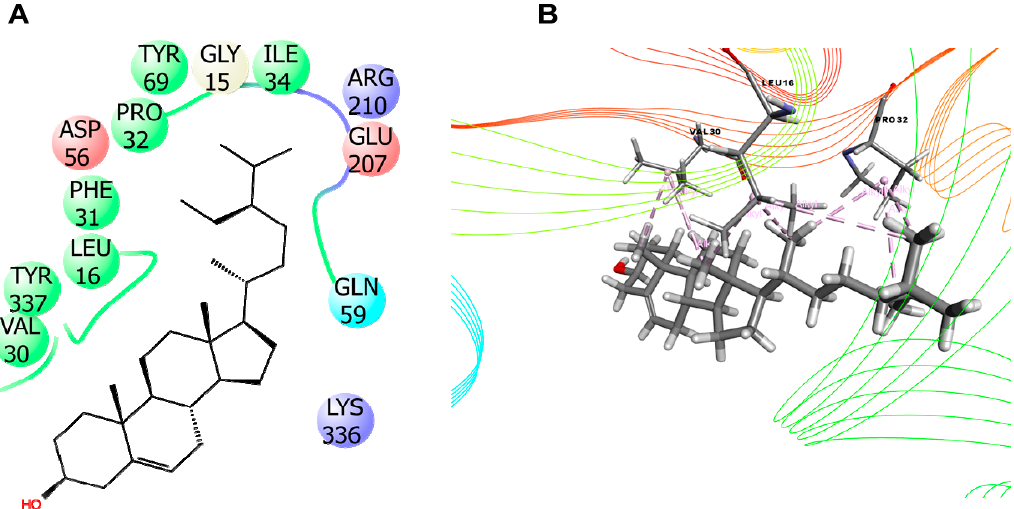
Figure 7. The best 2D ( A ) and 3D ( B ) representation of the interactions between beta-sitosterol with V. cholerae MARTX toxin (PDB ID: 3CJB).